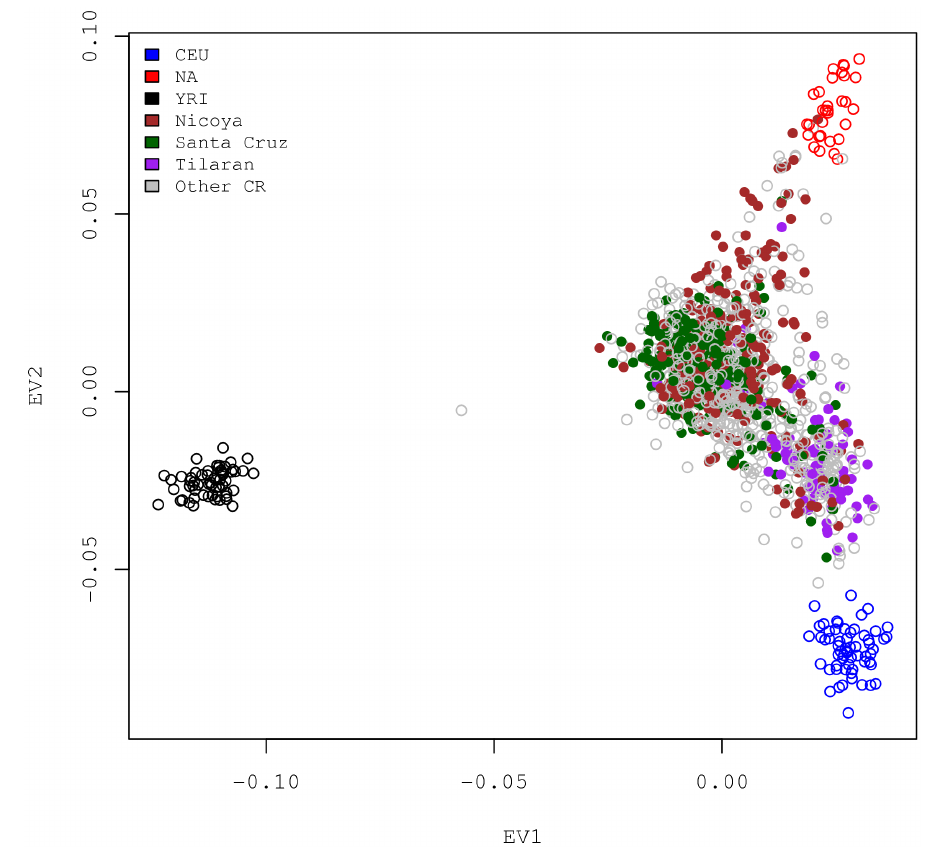
Figure 6. Substructure mirrors geographic location. The principal components analysis was performed on the refined CR samples (excluding 56 with greater than 10% Asian ancestry) together with three reference populations (CEU, NA and YRI). Three cantones (Nicoya, Santa Cruz and Tilaran) in Guanacaste are shown to have distinct distributions in the EV1versus EV2 scatter plot.